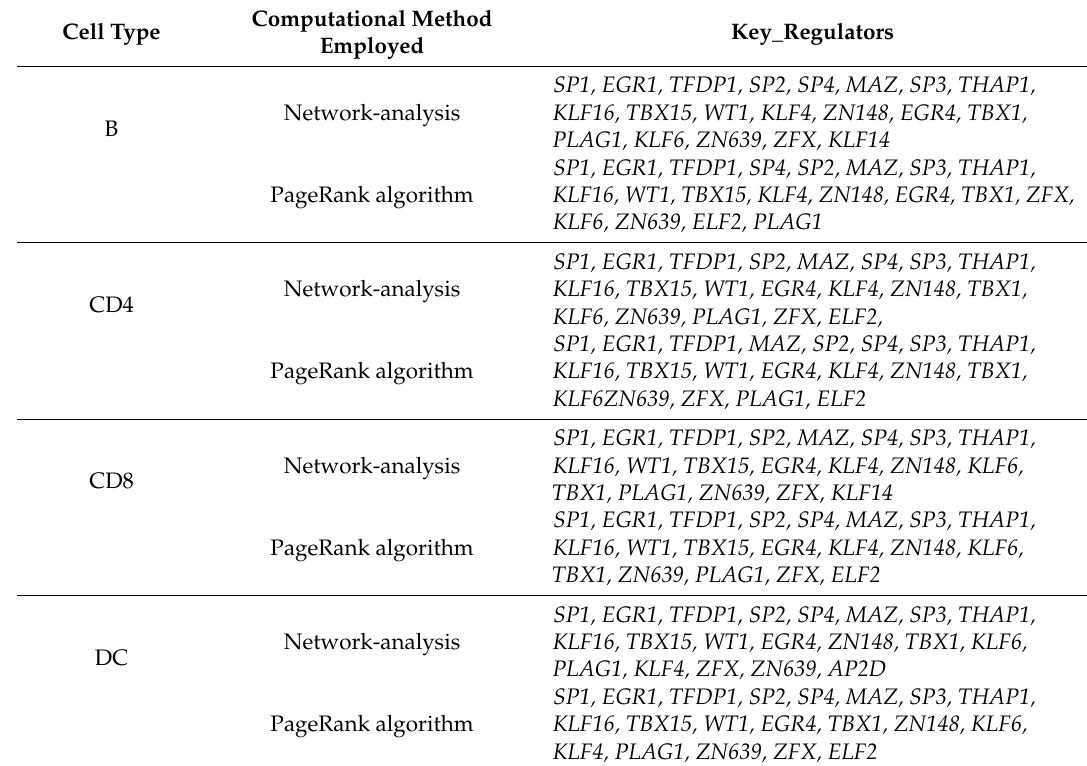
Table 3. Key regulators in the gene regulatory networks of immune